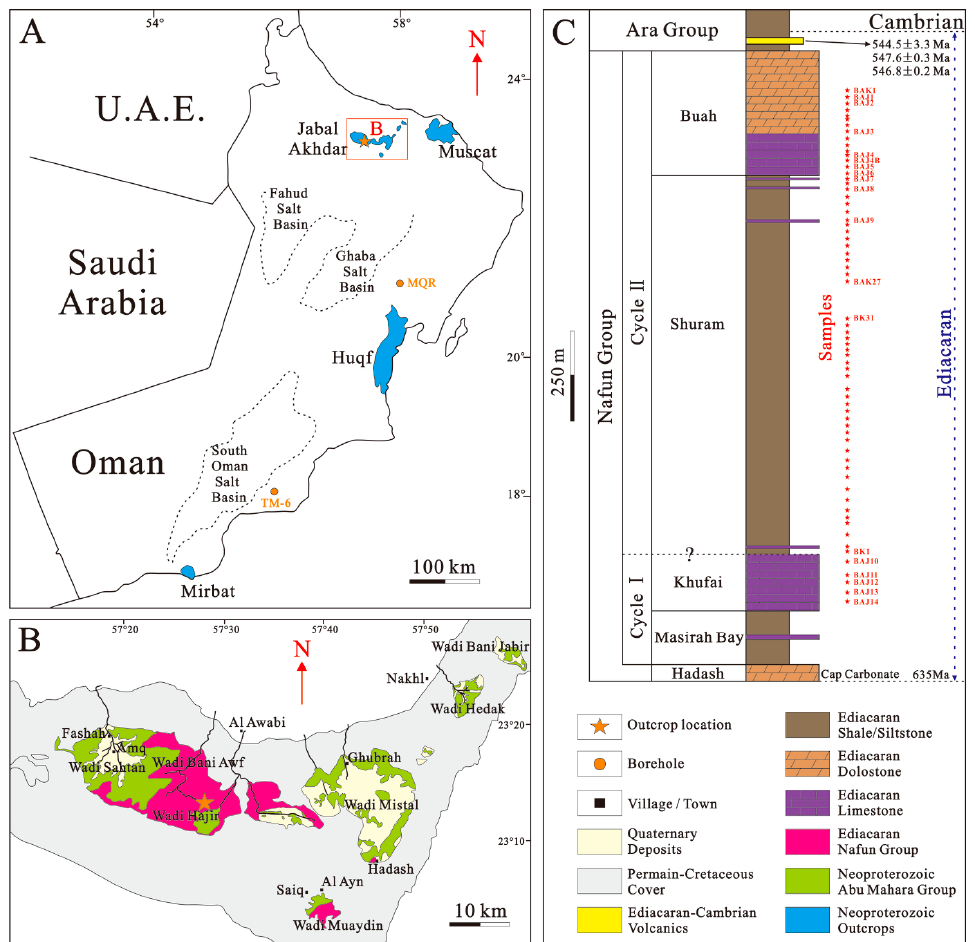
Figure 1. ( A ) Regional map of Oman with the Neoproterozoic outcrops and salt basins. ( B ) Schematic geologic map of Jabal Akhdar area. ( C ) Stratigraphic column of the Nafun Group. Modified after [1,33]; Age data source: [19,21].